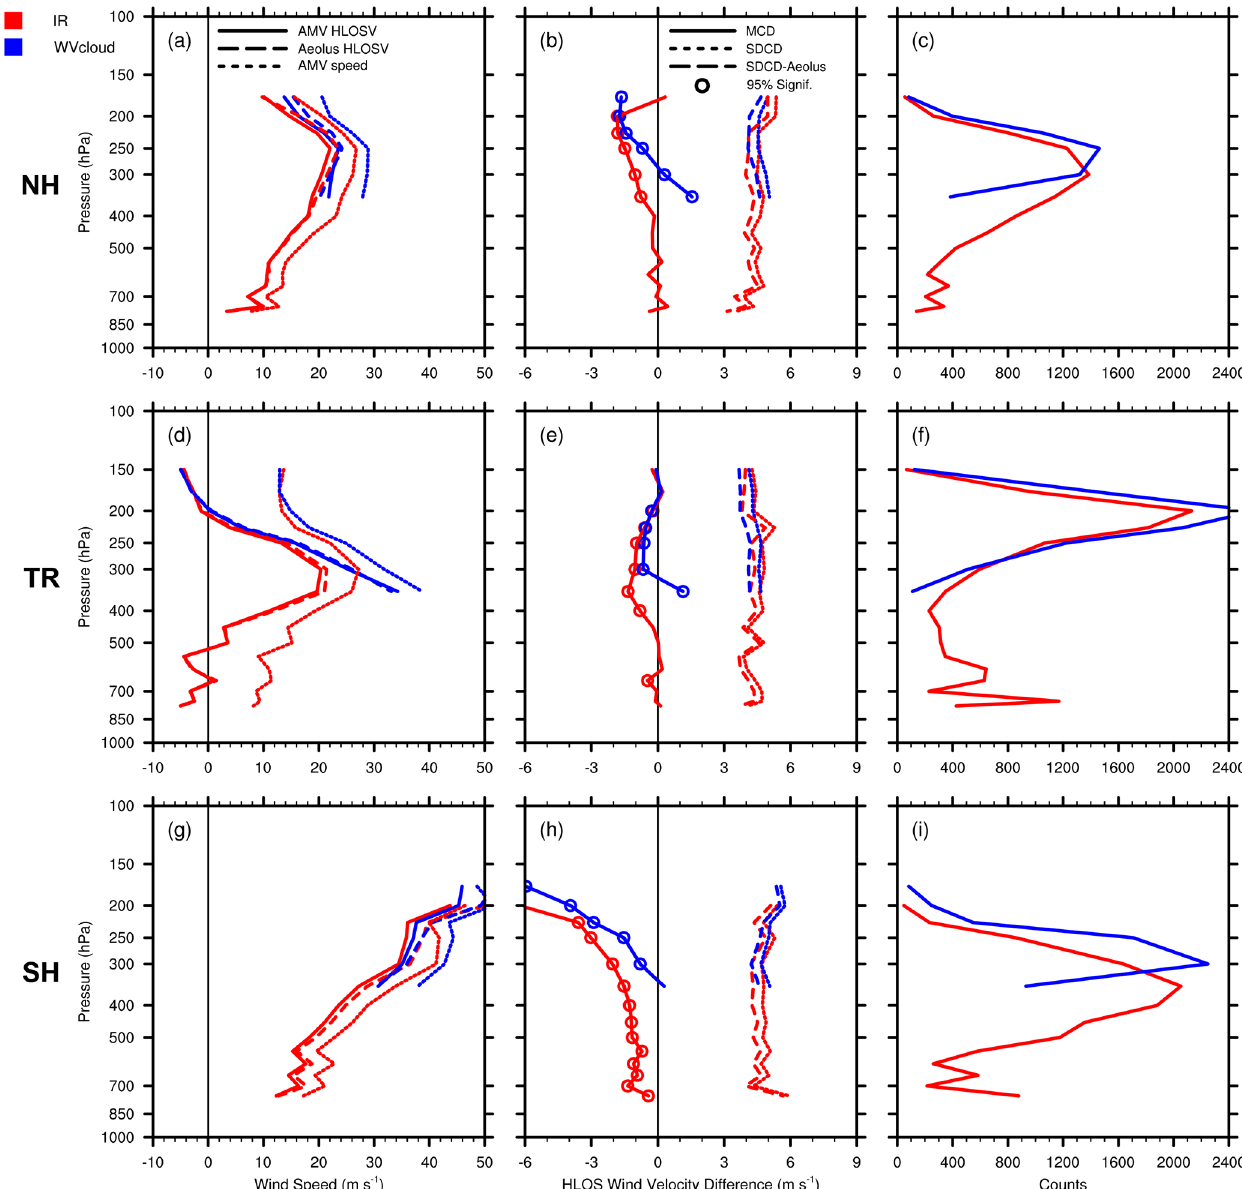
Figure 10. As in Fig. 7 but for comparisons of IR (red) and WVcloud (blue) AMVs and MIE winds.